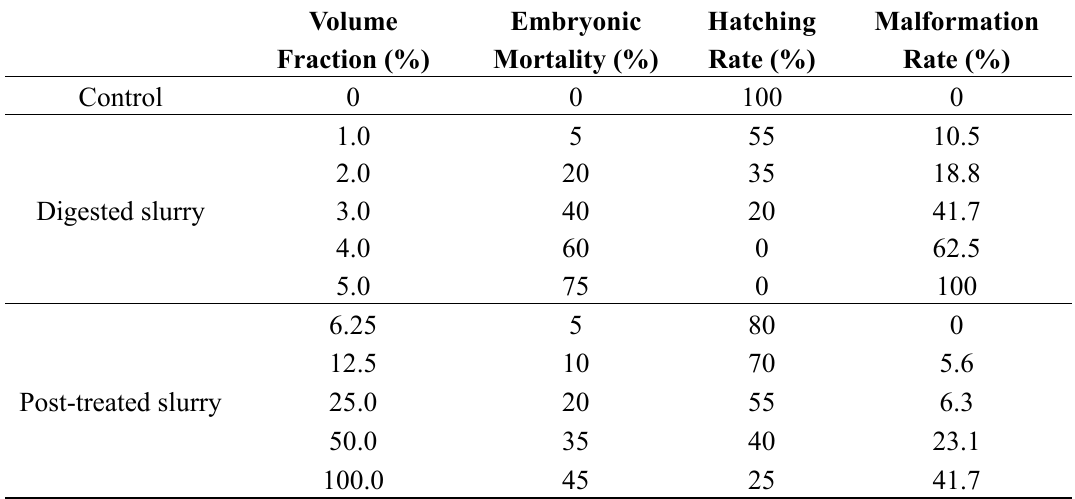
Table 4. Toxicity of digested and post-treated slurry to zebrafish embryo.